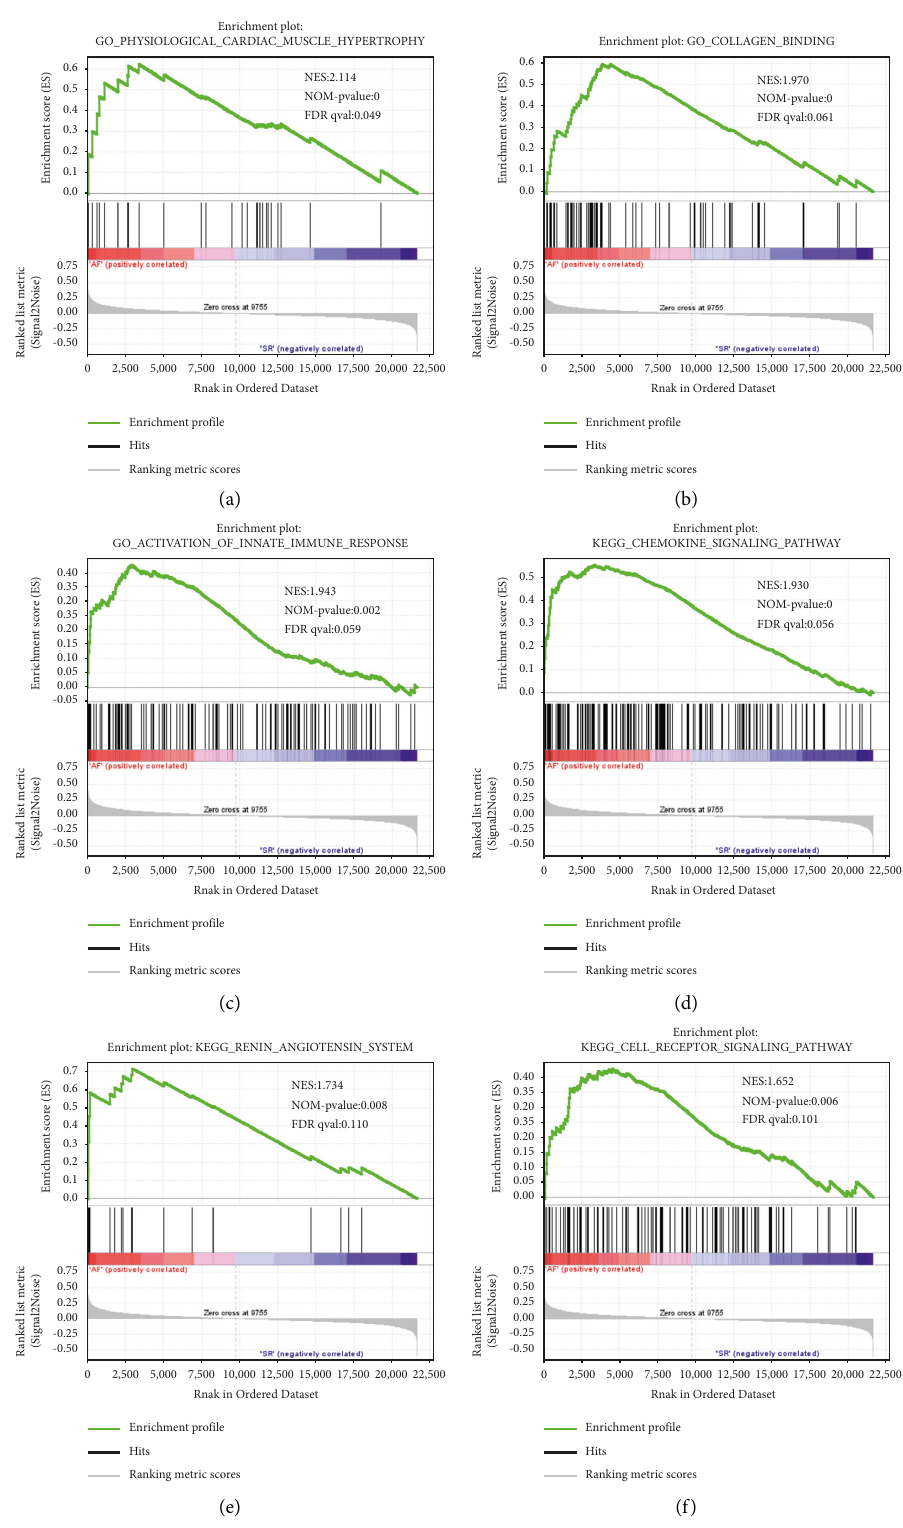
Figure 2: Enrichment analysis of mRNA integrated data set through gene set enrichment analysis (GSEA). GSEA results showing physiological cardiac muscle hypertrophy (a), collagen binding (b), activation of innate immune response (c), chemokine signaling pathway (d), renin angiotensin system (e), and T cell receptor signaling pathway (f) are differentially enriched in atrial